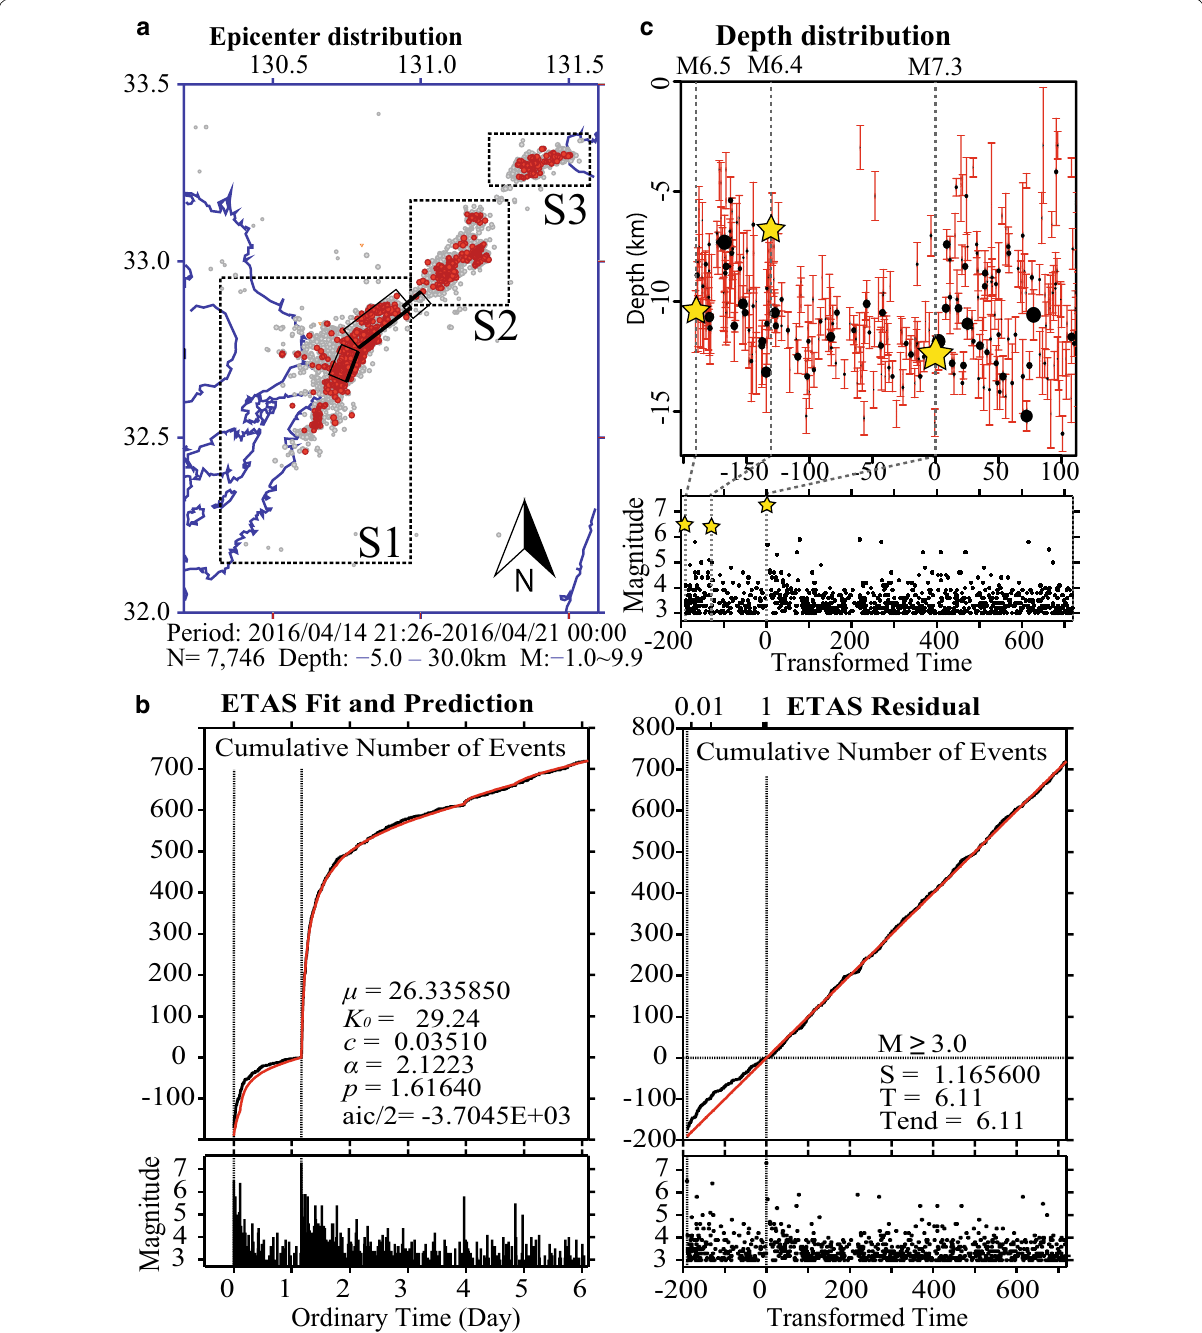
Fig. 6 Epicenter distribution, ETAS model estimate, and depth versus time plots of the foreshocks and aftershocks. a The epicenter distribution, where gray disks indicate events with magnitudes less than M3 and red disks indicate those larger than M3. The small rectangles indicate the fault models of the M6.5 and M7.3 ruptures (see Table 3). b The results of the ETAS model fitted to the above threshold ( M c region (red dots in a )), where data in the target interval are after the M7.3 mainshock. c The depth distribution of earthquakes in region S1 versus the transformed time. The vertical bars indicate the error bounds of the hypocenter depths. The stars indicate the earthquakes of magnitudes 6.5, 6.4, and 7.3 from left to